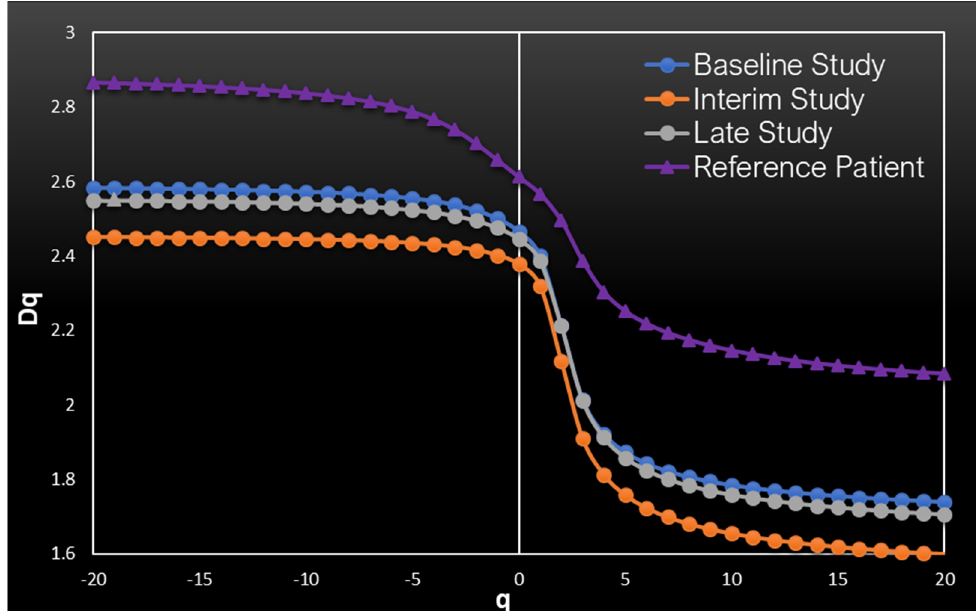
Figure A4. Typical MFS spectrum of patient with PMD. The blue line corresponds to the baseline study of patient P11, the orange line corresponds to the interim study and the gray line to the final study of the same patient. For comparison, the purple line representing healthy control H5 is also depicted.